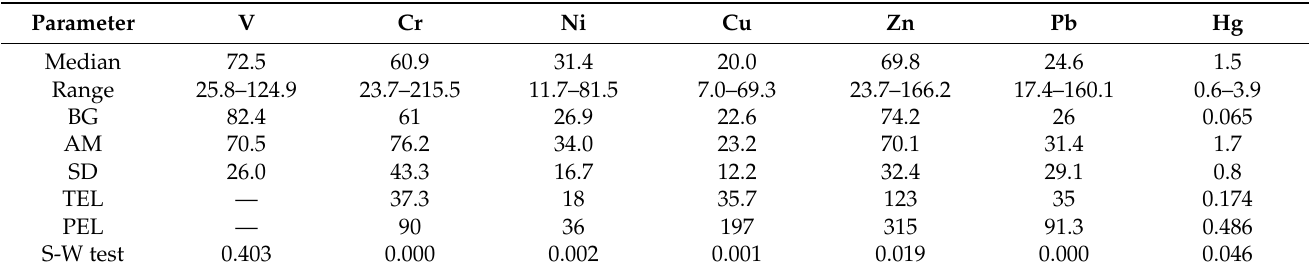
Table 6. The heavy metal contents (mg/kg) and descriptive statistics in soil of Linyi City ( n = 37), and the local soil background values.